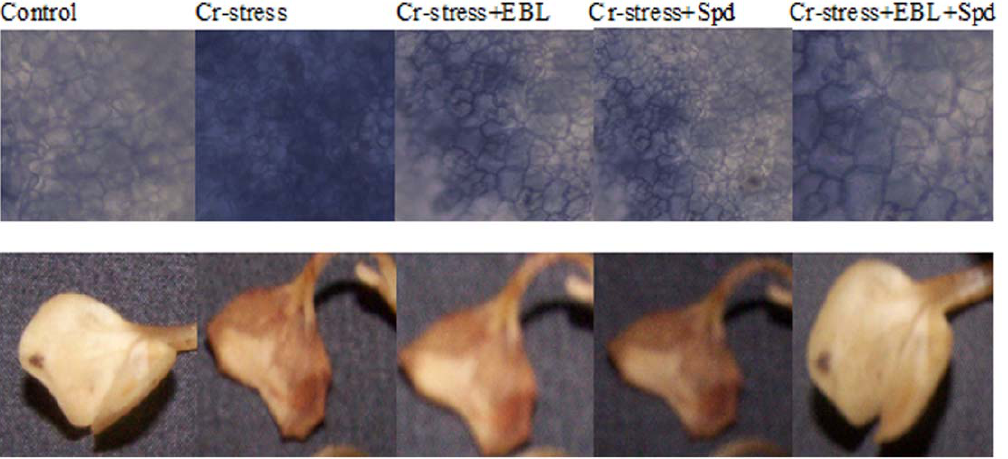
Figure 5. Localization of O 2 2 with NBT staining (upper panel) and H 2 O 2 with DAB staining (lower panel) in cotyledonary leaves of 7- d-old radish seedlings under Cr-stress without or with EBL and /or